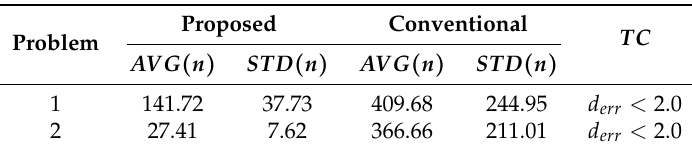
Table 2. The averages ( AVG s) and standard deviations ( STD s) of the number of iterations n for the methods to satisfy the termination condition ( TC ).